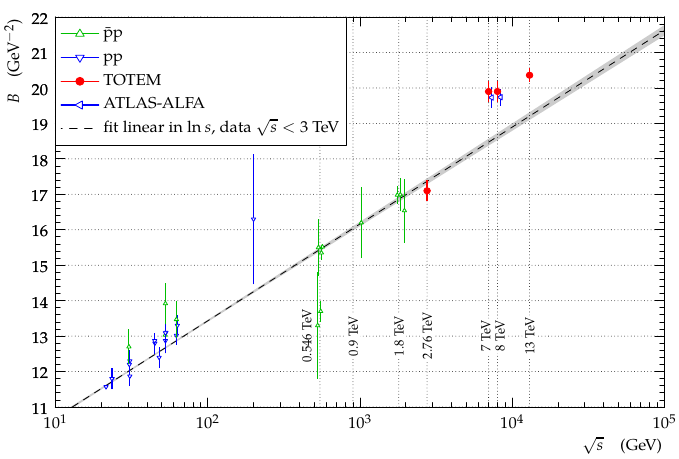
Fig. 4. The energy dependence of the slope B of the diffraction cone [8]. Figure 4. The energy dependence of the slope B of the diffraction cone